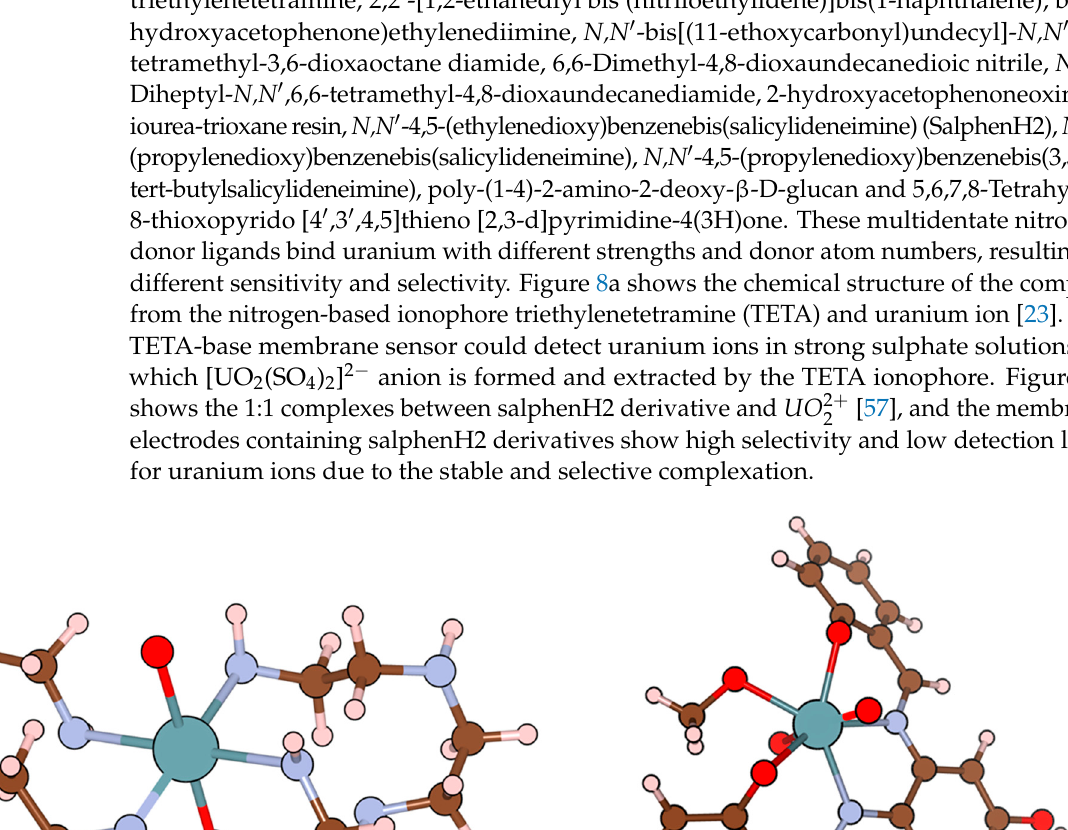
Table 4. An overview of uranium detection by PVC-based membrane electrodes with nitrogen-con- taining ligand-based ionophores.